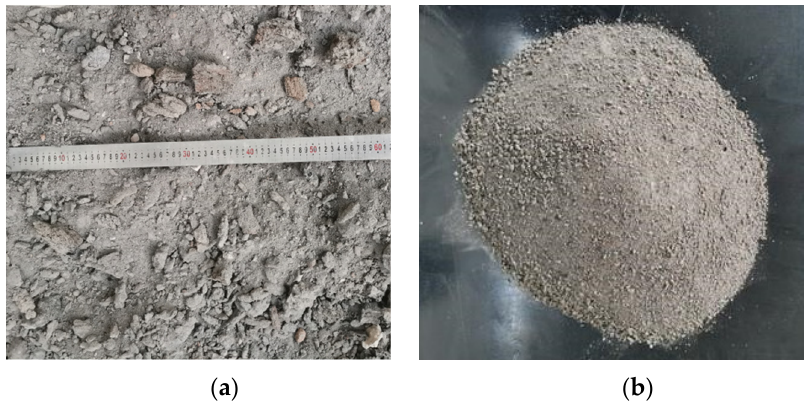
Figure 3. ( a ) Natural slag and ( b ) screened slag. Table 4. Proportions of mixture components.